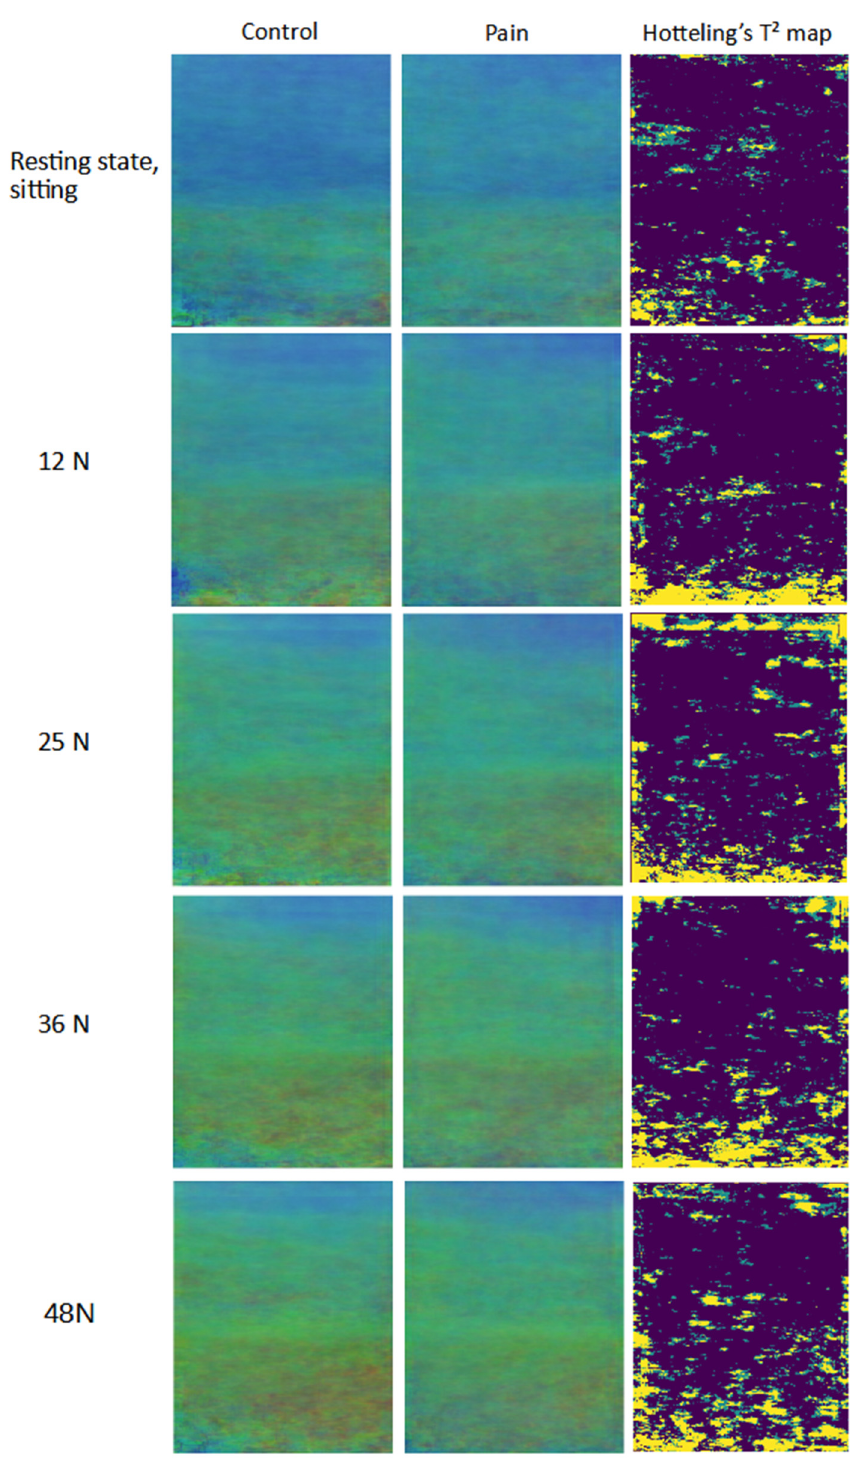
Figure 5. Summary mean images of the elastograms’ RGB values of the neck muscles with graded neck extension; Hotelling’s T 2 test map—green color p -value < 0.05—yellow color p -value < 0.01. In participants with neck pain, we note higher stiffness in the upper half of the image (superficial muscles) during the resting state in sitting, and less stiffness in the lower half of the images (deep muscles) during active neck extension.